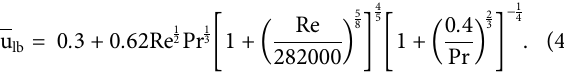
Frontiers in Energy Research |